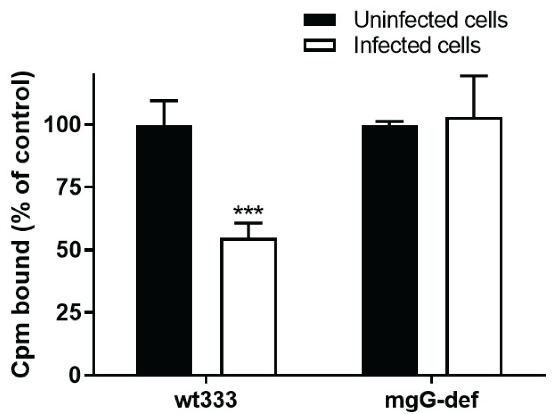
Figure 6. GMK AH1 cells were inoculated with the strain wt333, and 24 h later purified methyl- 3 H- thymidine labeled mgG deficient or wild type virions (adjusted to 1.7 × 10 7 DNA copies) were added and incubated with cells for 2 h at 37 ◦ C. The results are expressed as a percentage of the number of counts per minute (cpm) bound to infected cells relative to that bound to non-infected control cells. Values shown are means ( ± SD) of data from two separate experiments performed in duplicates. The mean number of cpm bound to non-infected cells were 1053 and 554 for wt333 and mgG-def virions respectively. Statistically significant differences as related to uninfected cells at p values of <0.005 (***).